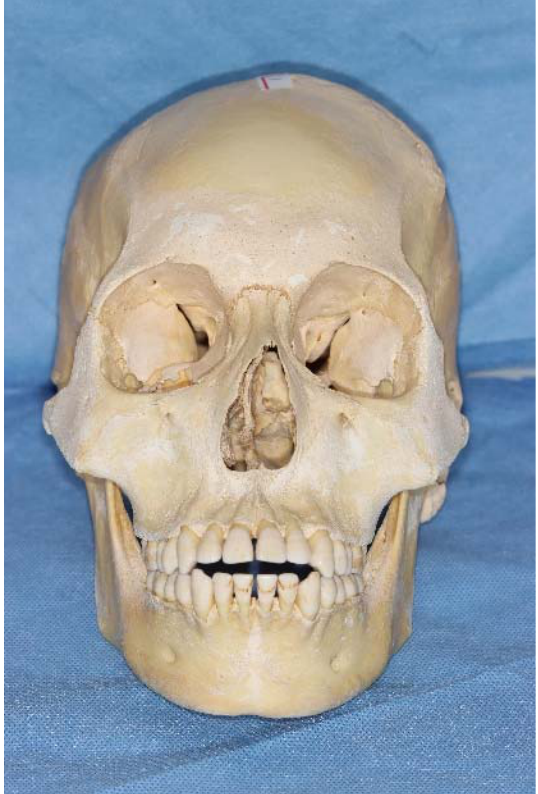
Figure 1. A human skull specimen was selected as the research object.